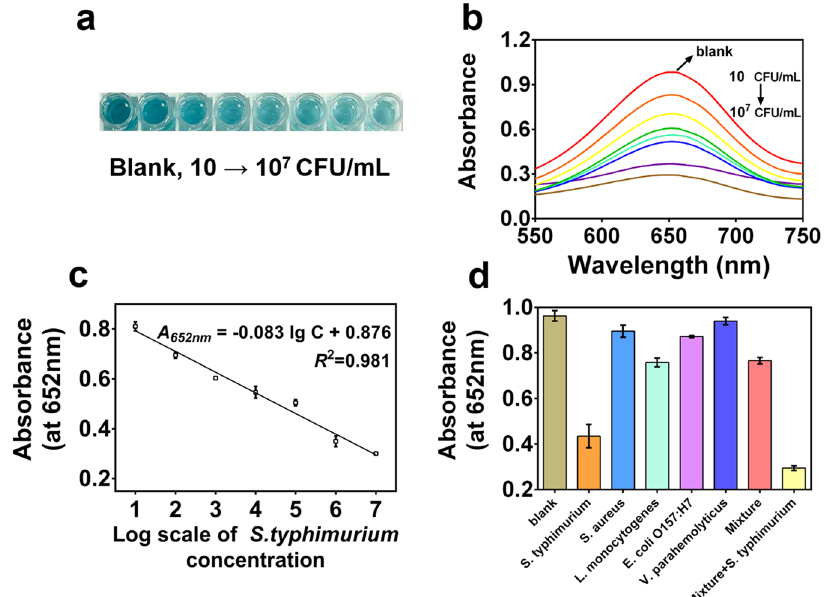
Fig. 5 Sensitivity and selectivity. a Photographs and b UV – Vis spectra of the colorimetric assay with different concentrations of S. typhimurium (from 1 × 10 to 1 × 10 7 CFU/mL), c the calibration curve for detecting S. typhimurium (the A 652nm value vs. the log scale of S. typhimurium concentration), d the A 652nm value of colorimetric results of different bacteria samples (blank, S. typhimurium , S. aureus , L. monocytogenes , E. coli O157:H7 , V. parahaemolyticus , mixture, and mixture + S. typhimurium ). Error bars represent the standard deviation of three